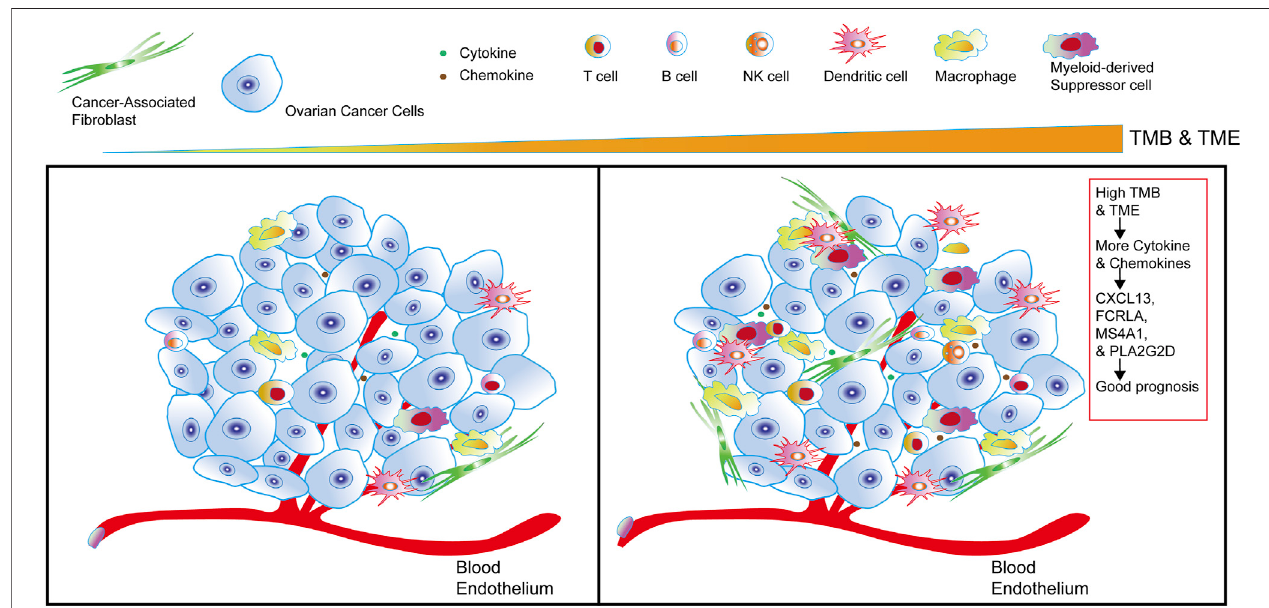
FIGURE 8 | The sketch of integrating TMB and TIME to identify good prognostic gene sets of OC. The sketch illustrates from left to right that in OC cells, with the higher theTMBandthemore cytokinesand chemokines inthetumor,themore immune in fi ltrating cellsinOC.Combining thecomprehensiveanalysisofTMB andTIME to obtain a set of genes — CXCL13, FCRLA, PLA2G2D, and MS4A1, it ’ s closely related to the good prognosis of